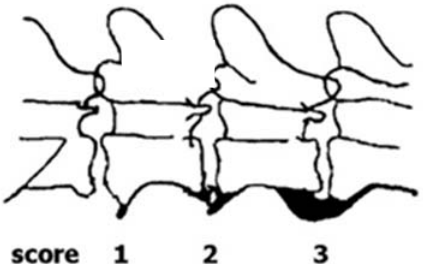
Figure 1. The Norwegian scoring system of enthesophyte development in dogs (reproduced from [10] with permission from J Small Anim Pract ). A score of 0 (not shown) corresponds to no enthesophyte development.